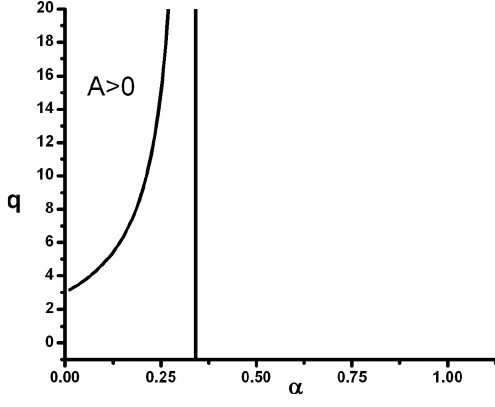
Fig. 1. Parameter A in q – α space. tensive parameter. Absolute value of the soliton amplitude ϕ 0 increases when q increases (i.e. the long-range interac- tion between hot electrons is not negligible). Increasing the soliton amplitude is more sensible for the larger values of γ (smaller values of l z ). This figure also shows that the soliton amplitude is an increasing function of γ . Thus the soliton amplitude finds its maximum values in smaller values of l z as mentioned